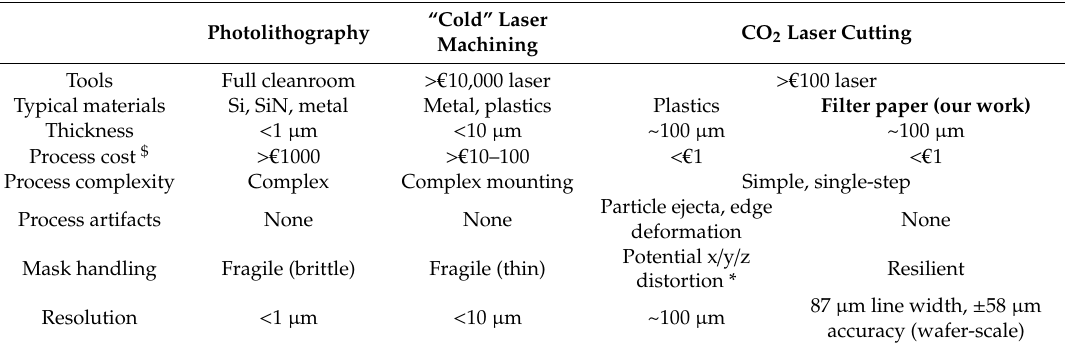
Table 1. Overview of select shadow mask fabrication